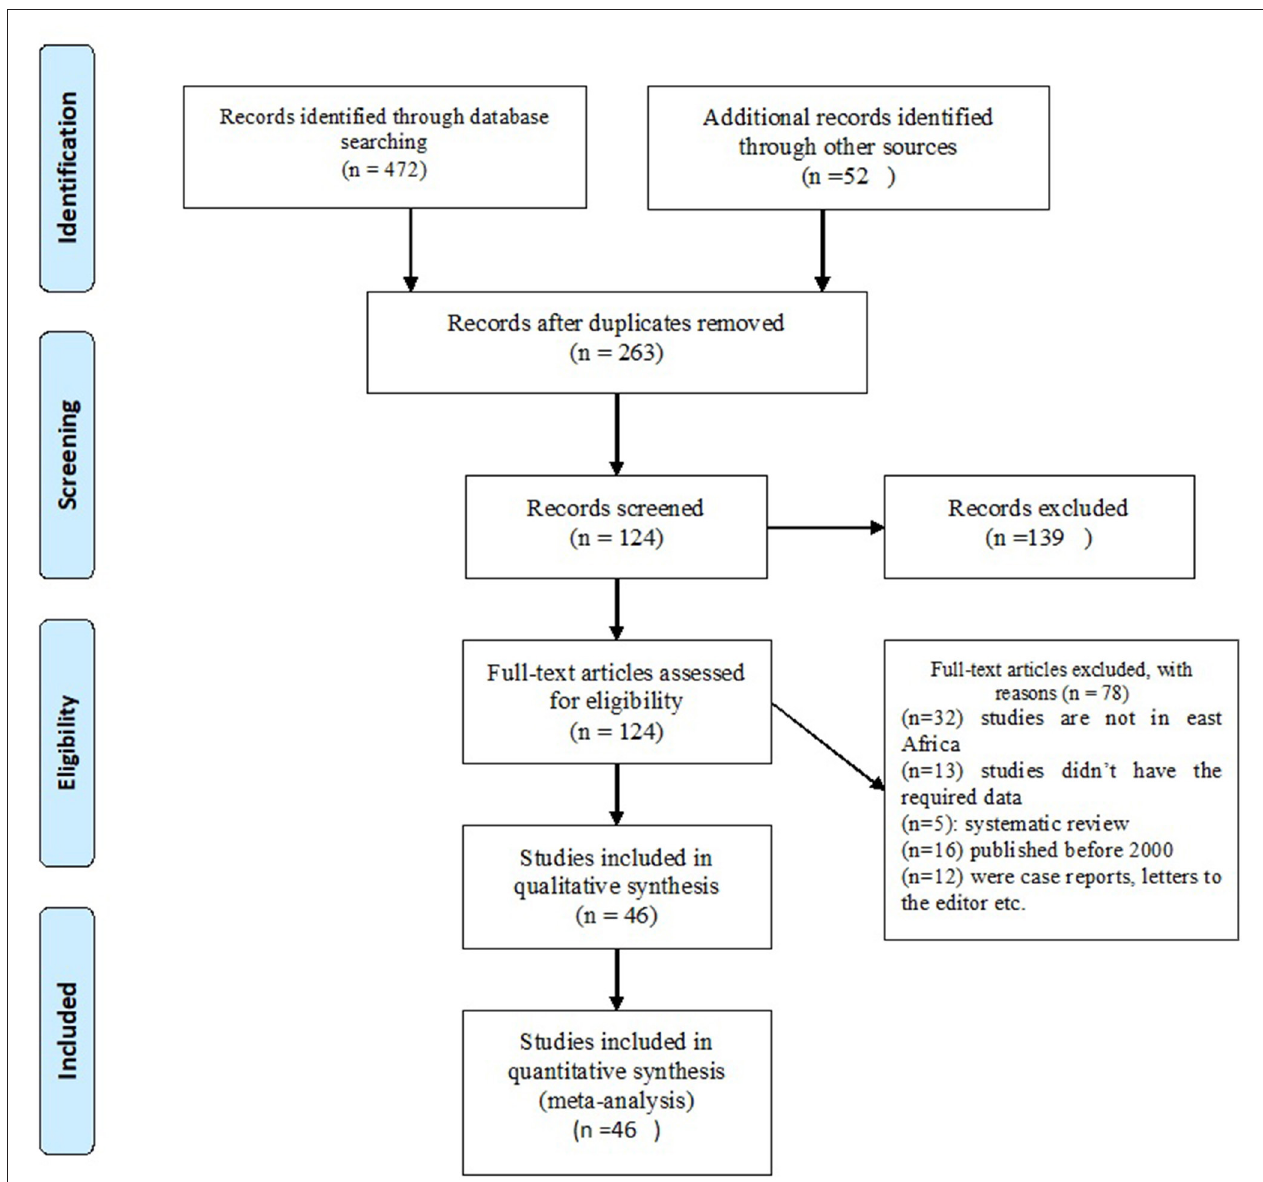
FIGURE 1 | PRISMA flow diagram showing the article selection